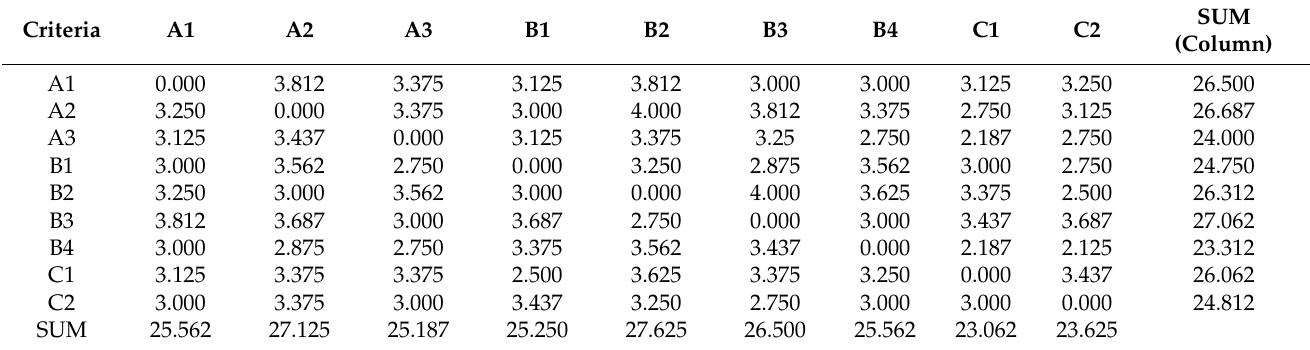
Table 1. Direct-Relation Matrix.